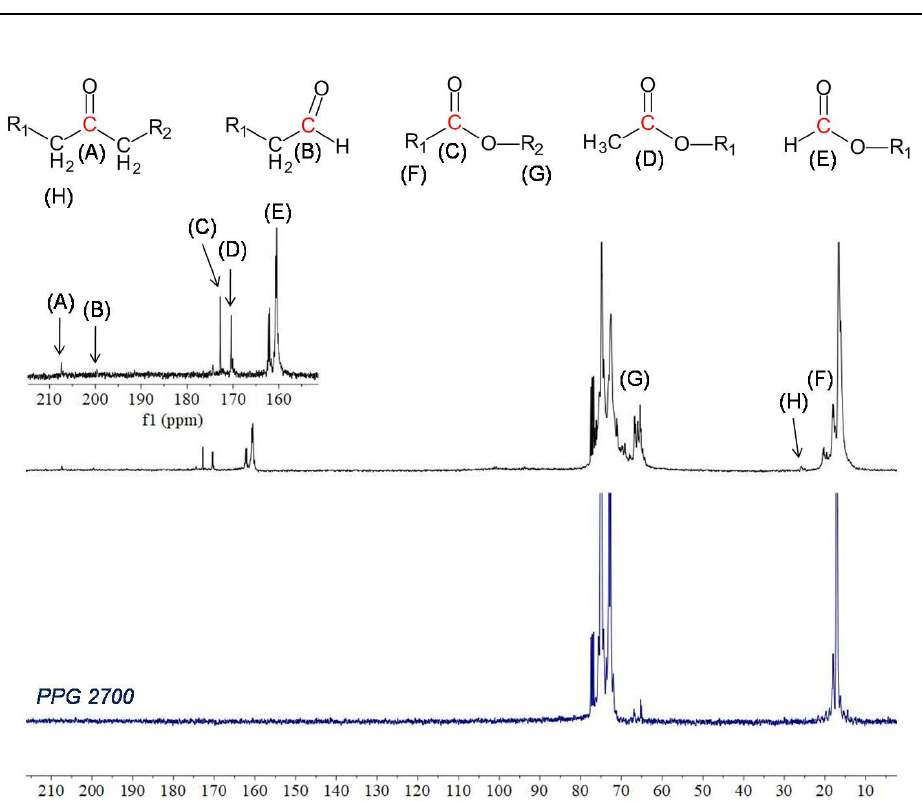
Figure 6. 13 C NMR spectra (CDCl 3 , 100 MHz) of raw PPG2700 (blue) and PPG2700 exposed to UV radiation (black). Inset: enlarged region within the 150–210 ppm spectral range after UV exposure.